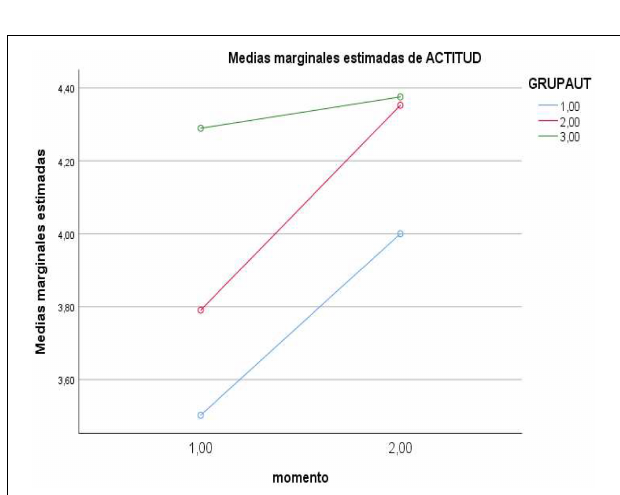
FIGURE 2 | Effects of Moment × Level of regulation on self-regulation (1 = low; 2 = medium; 3 = high).